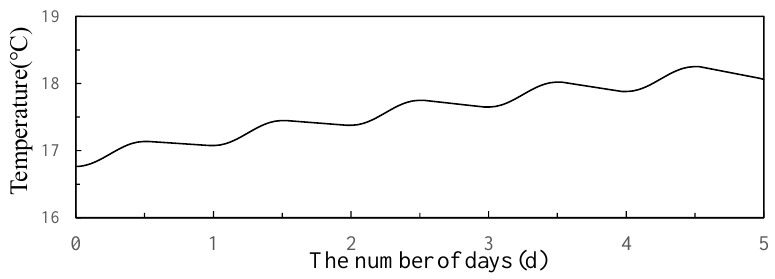
Figure 10. Temperature field of the arch dam influenced by the solar radiation during one day in summer.